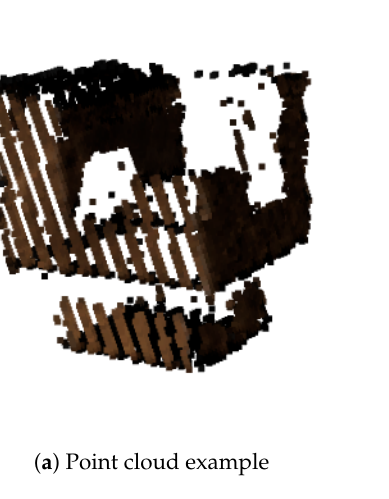
Figure 4. Transformation from a point cloud to a voxel